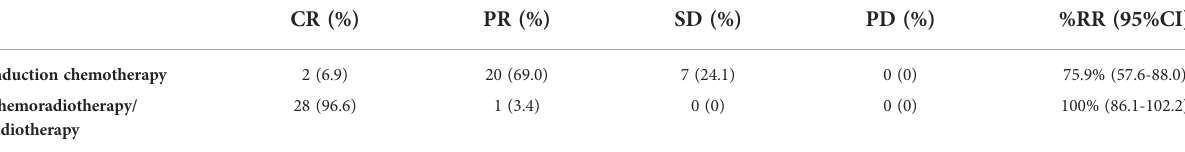
TABLE 2 Response to treatment by RECIST